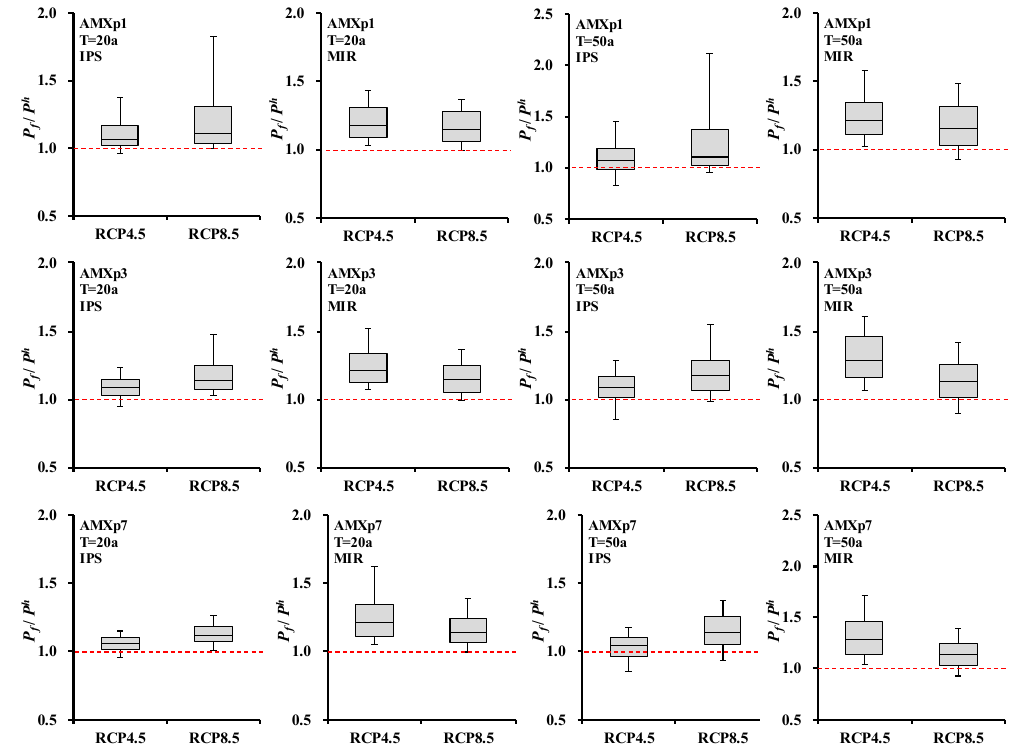
Figure 7. Boxplot of AMX n p- T yr ( n = 1, 3, 7; T = 20a, 50a) change in each grid-box for different RCPs and GCMs. Y -axis is the ratio of projected value ( P f ) to historical value (P h ). P f / P h > 1 means the increase of AMX n p; P f / P h < 1 means the decrease of AMX n p. The box portion represents the 25th, 50th to 75th percentile, and the whiskers represent the 10th percentile and the 90th percentile.